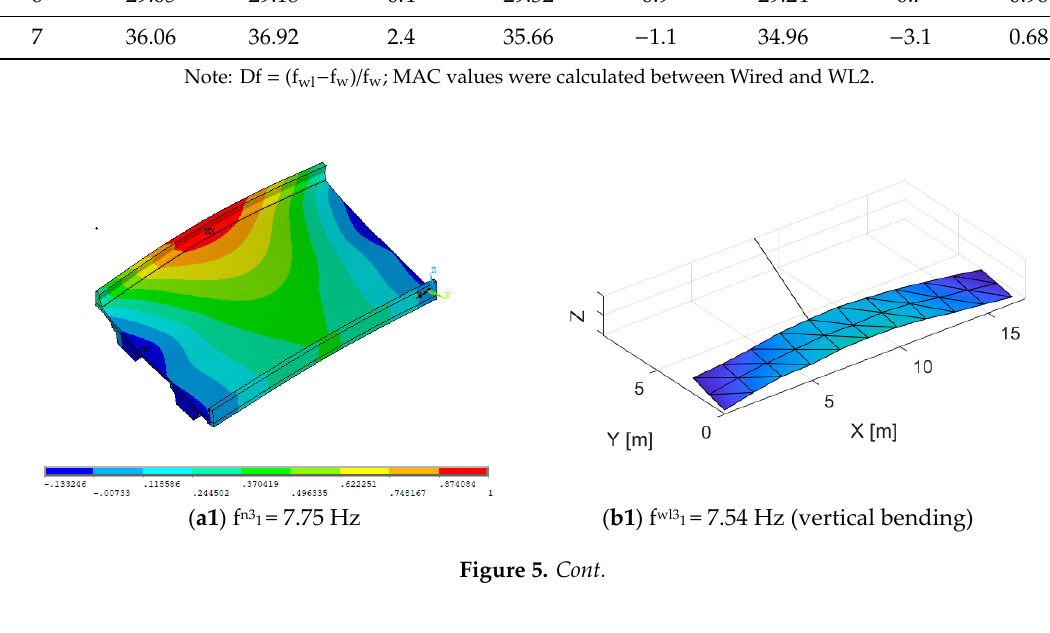
Table 1. Experimental modes as identified from the measurements.